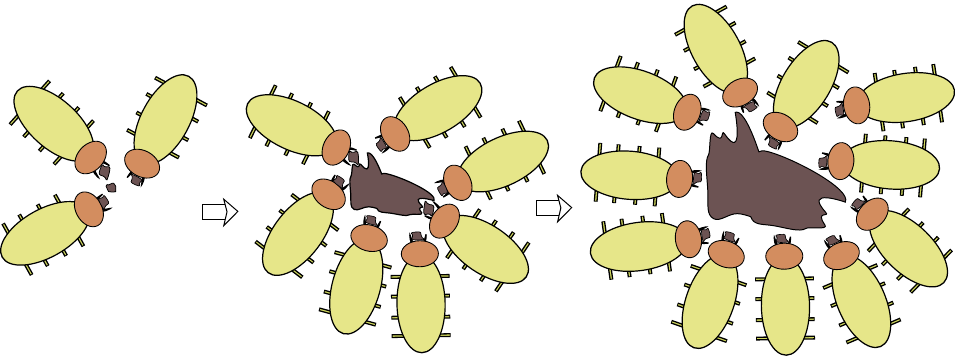
Figure 2. Termites sharing a working area.